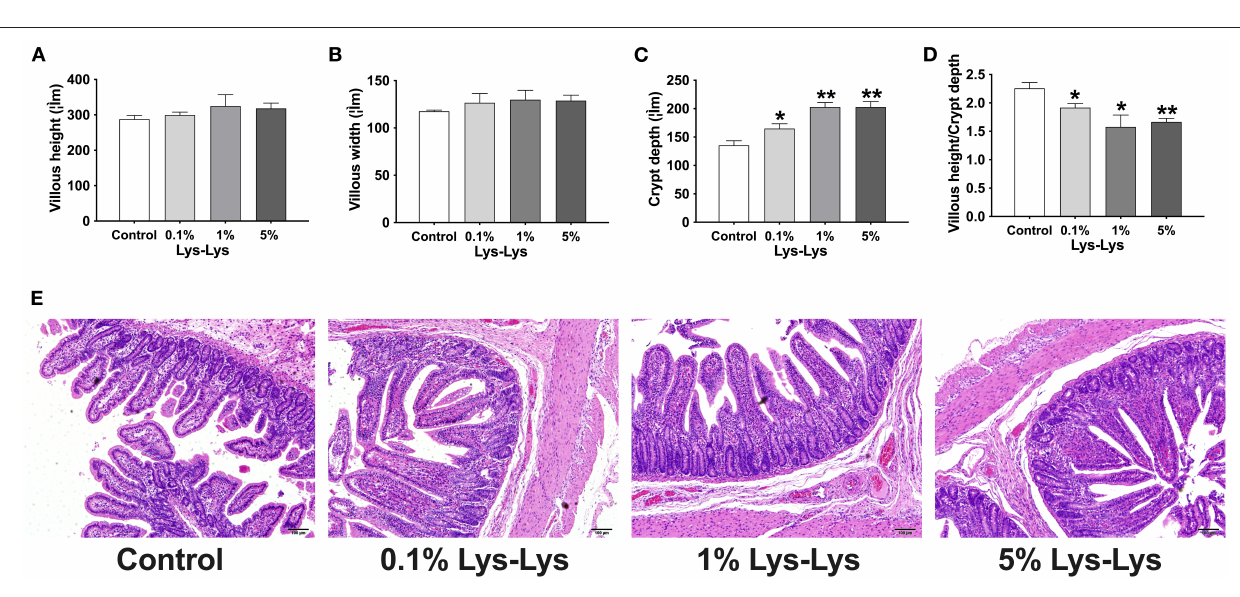
FIGURE 2 | Effect of the Lys-Lys dipeptide on morphological characteristic of the ileum in piglets. (A) Villous height, (B) villous width, (C) crypt depth, and (D) villous height/crypt depth. (E) H&E staining of the ileum in piglets. Scale bar = 100 µ m. Data were expressed as the mean ± SEM ( n = 7). *Different from control, P < 0.05; **different from control, P <